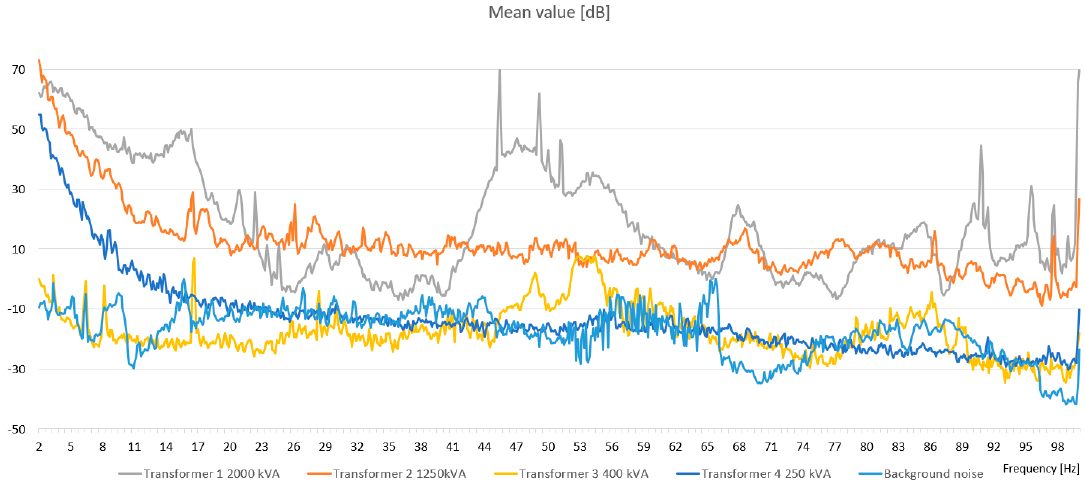
Figure 4. Photos of the tested power transformers: ( a ) first, ( b ) second, ( c ) third, and ( d ) fourth.